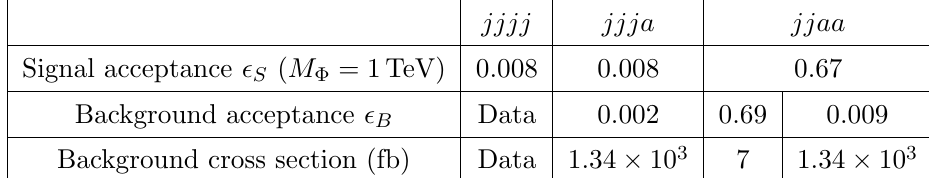
Table 4 . Acceptances for signal and backgrounds for the three (cid:12)nal states we study, after the cuts in table 3. The signal corresponds to BP2, but the acceptances are rather independent on the mass value, while the background cross sections ae calculated after imposing a cut on the scalar sum of the p T of the outgoing particles p T; sum > 1500 GeV. For jjaa , we show separately for the